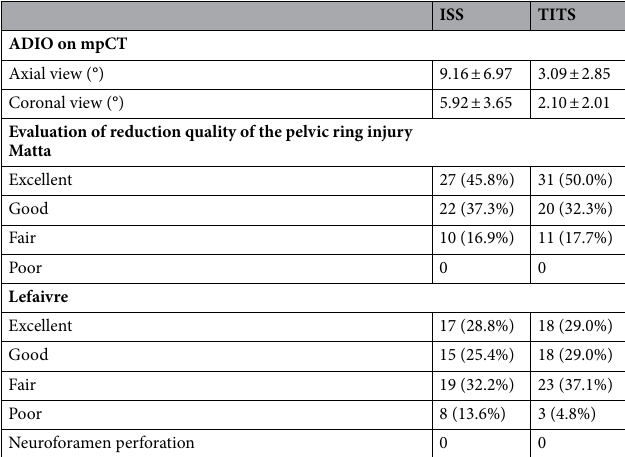
Table 3. Surgical results of the patients with percutaneous surgery for the pelvic ring injuries. ISS iliosacral screw, TITS trans-iliac trans-sacral screw, ADIO angle deviated from ideal orientation, mpCT multi-planar computed tomography.